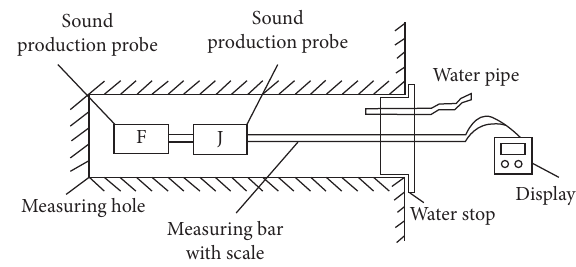
Figure 2: Principle of acoustic wave test.